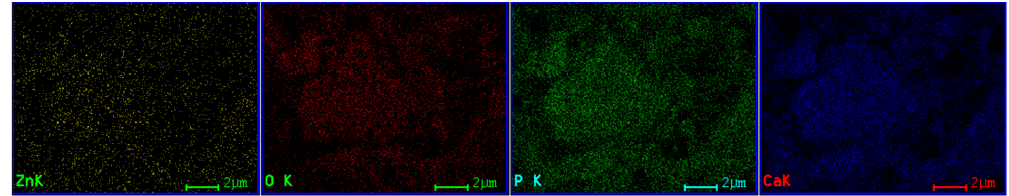
Figure 10. Representative image of ZnHApD powders ( a ) and size distributions ( b ) obtained by scanning electron microscopy (SEM).